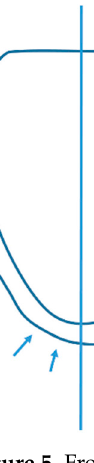
Figure 5. From CBCT. the labial bone height of the mandibular incisor was measured only at the line along the center, whereas from the cephalogram, the occlusal margin of the bone nearby the center of the alveolar crest (arrows) appeared on the film and could be measured.